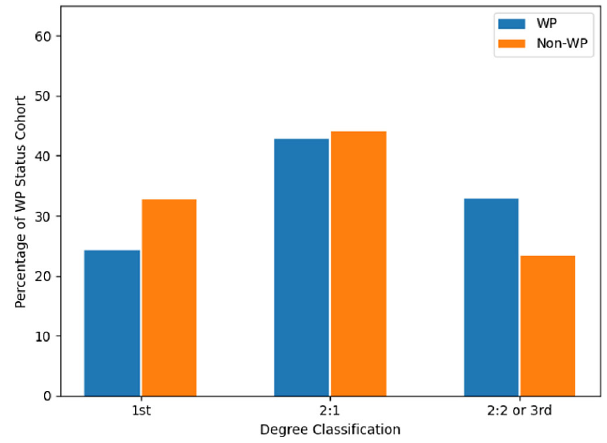
FIG. 6. Proportional split of classifications achieved by stu- dents who exited with a BSc (Hons) or MPhys (Hons), disag- gregated by WP status ( N ¼ 220 , WP ¼ 70 , non-WP ¼ 150 ).